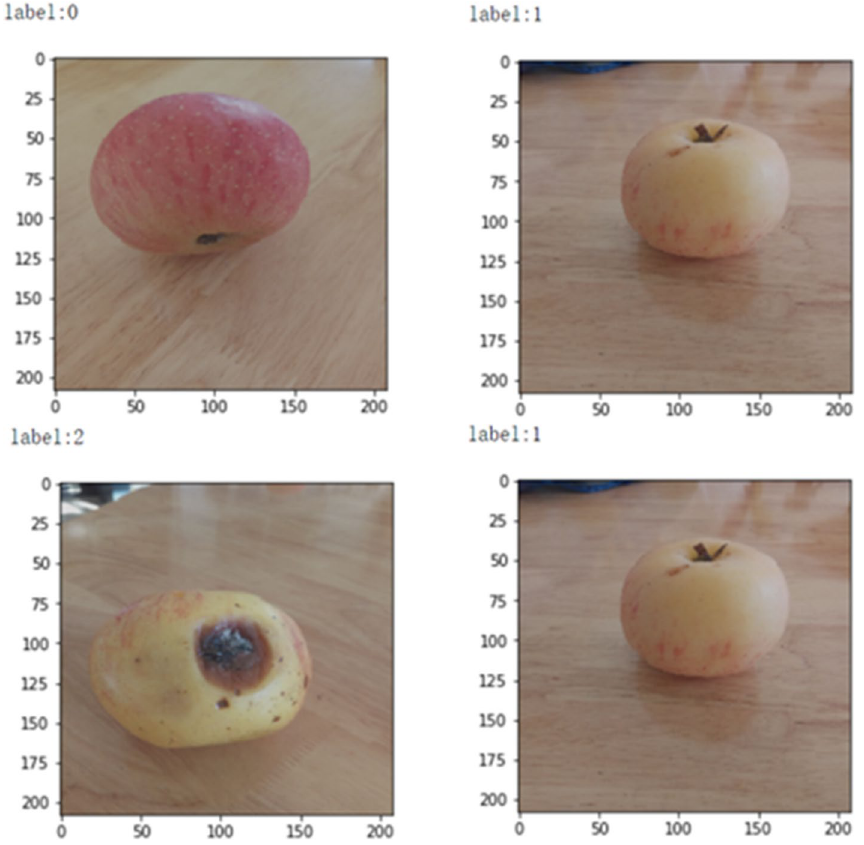
Figure 7. Representative preprocessed sub-images for proposed